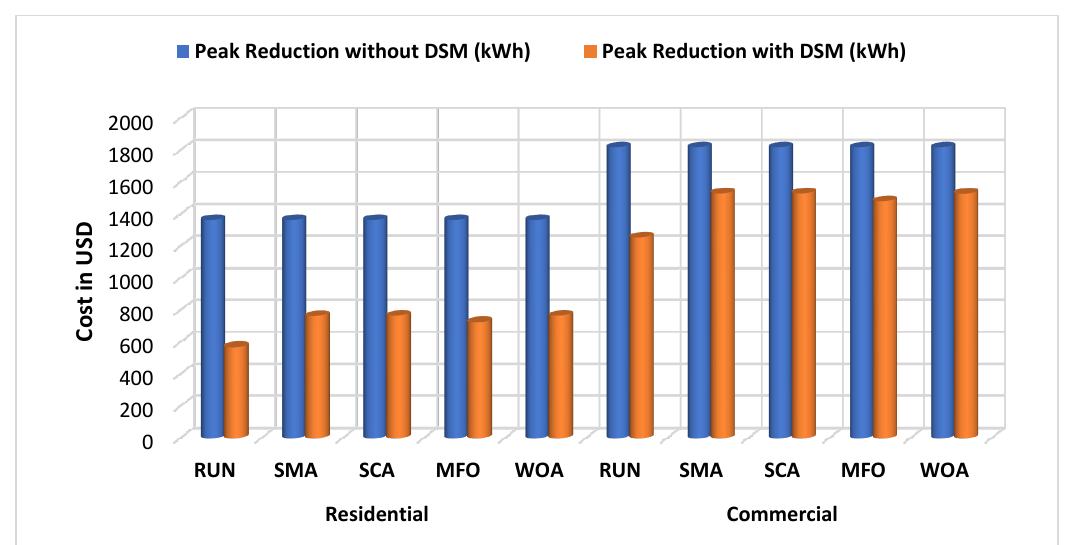
Figure 14. Peak demand reduction by load shifting.